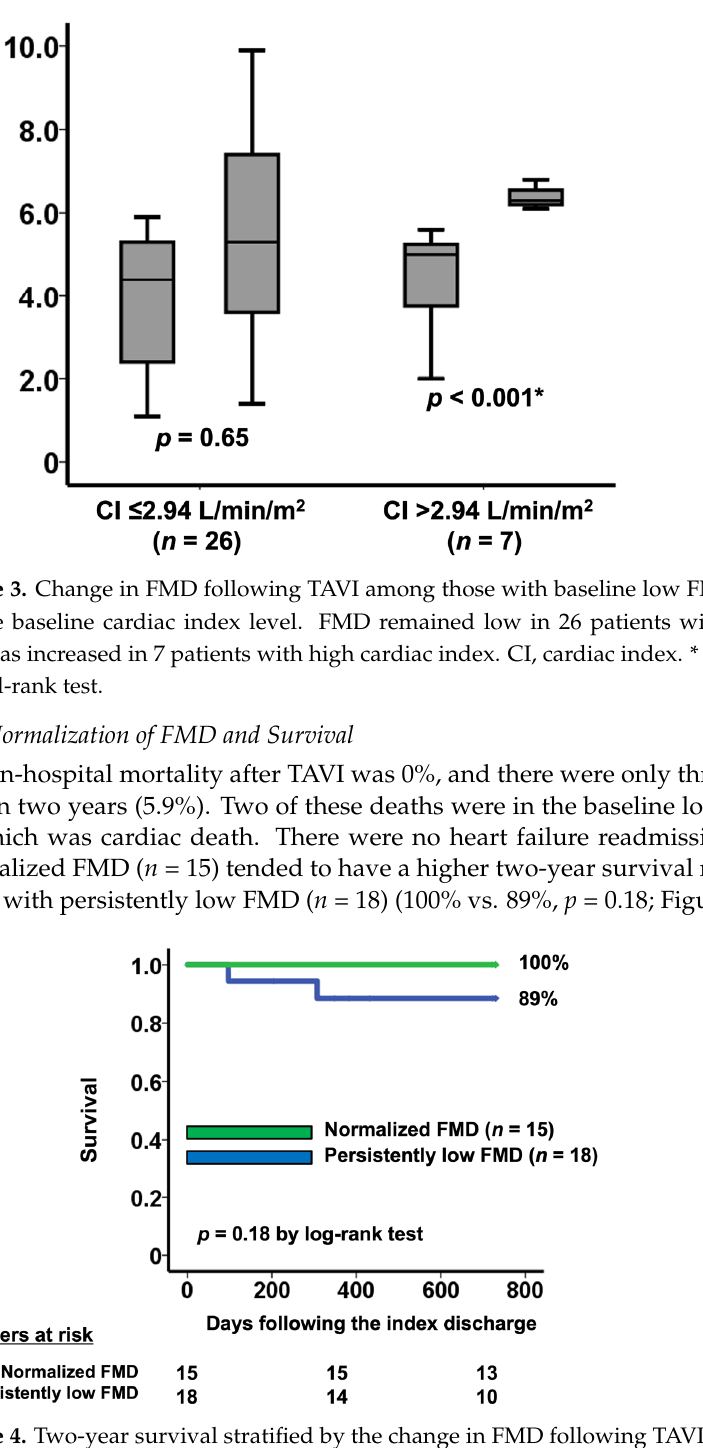
Figure 4. Two-year survival stratified by the change in FMD following TAVI. Patients with persistently low FMD had worse survival compared with those with normalized FMD.